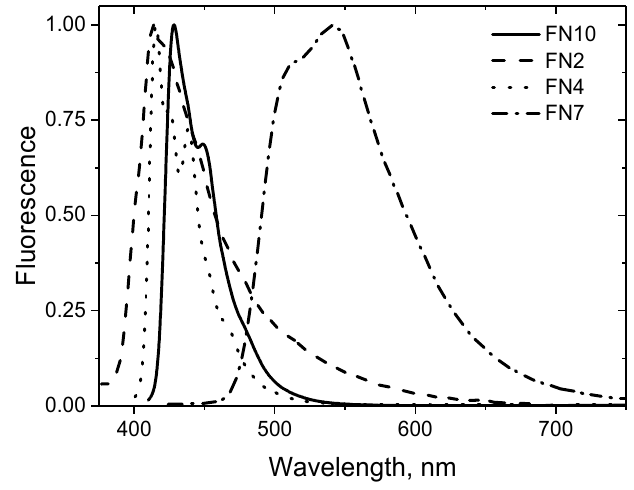
Figure 2. Fluorescence spectra of the selected dyes in ethyl acetate. Table 2. Quantum yield of the singlet oxygen formation ( Φ 1 O ( Φ T ), and initial rate of photoinitiated polymerization ( R p ) for the dyes tested.